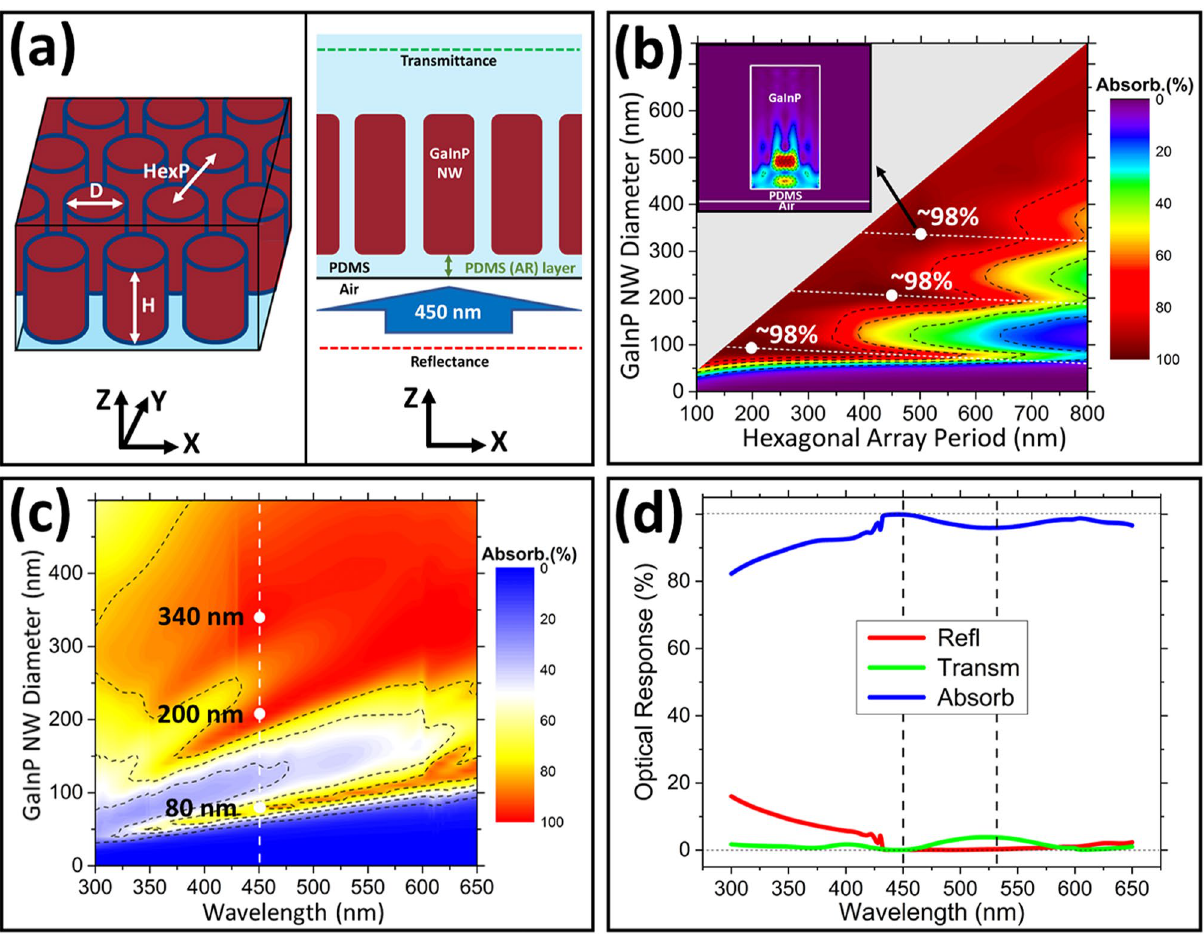
Figure 2. FDTD simulation results mapping the optimal geometrical parameters of the embedded GaInP NW arrays with a height (H) of 1 µm for 450 nm source light. ( a ) Schematics for the simulated embedded GaInP NW structures. ( b ) Contour plot showing the calculated absorbance (FoM) at 450 nm for the investigated diameters (Ds) and periods (HexPs). The white dots indicate the highest obtained FoMs. Inset: absorbed power distribution at 450 nm wavelength of incident light. ( c ) Contour plot for the FoM values for GaInP NW arrays with an H of 1 μm, HexP of 500 nm, and D swept between 0–500 nm. ( d ) The optical response (total reflectance, transmittance, and absorbance) for optimized GaInP NW arrays embedded in